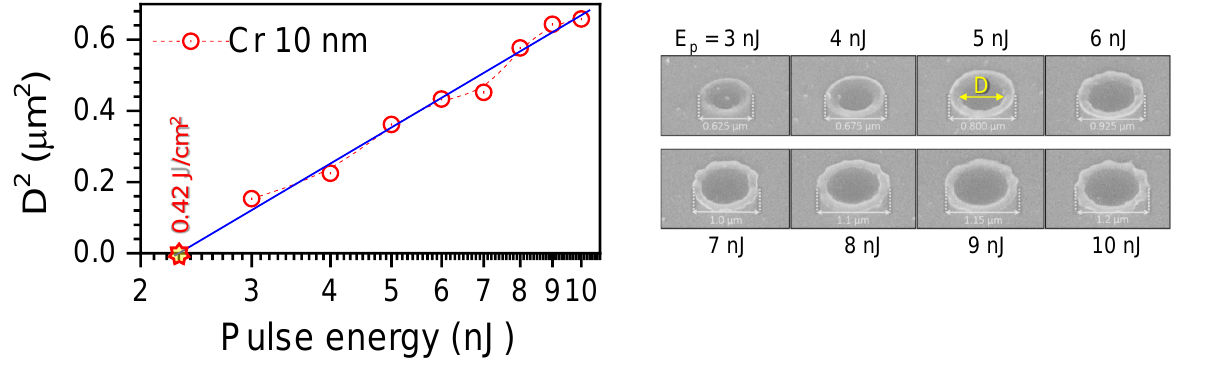
Figure A1. Central hole diameter D opened in a 10-nm-thick Cr film on Si under one pulse irradiation at different pulse energies E p (on the sample). Wavelength of laser pulse was 515 nm, pulse durartion 230 fs, focused by NA = 0.75 numerical aperture objective lens. Slanted-view SEM images show evolution of hole opening (diameter D ) at different pulse energies E p